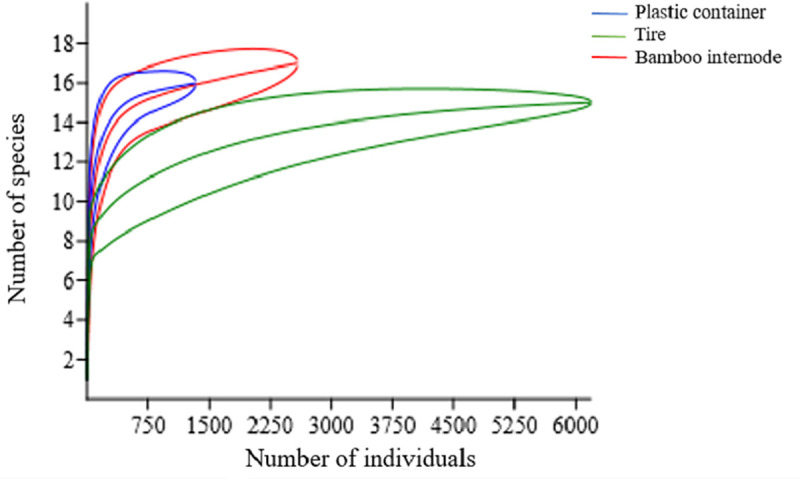
Collected species of mosquitoes.Rarefaction curves representing the accumulated richness of the immature mosquito species collected in plastic container, tire, and bamboo internode traps in the agrovillage of Rio Pardo, Presidente Figueiredo, Amazonas, Brazil periods of November 2017 and January–February 2018.